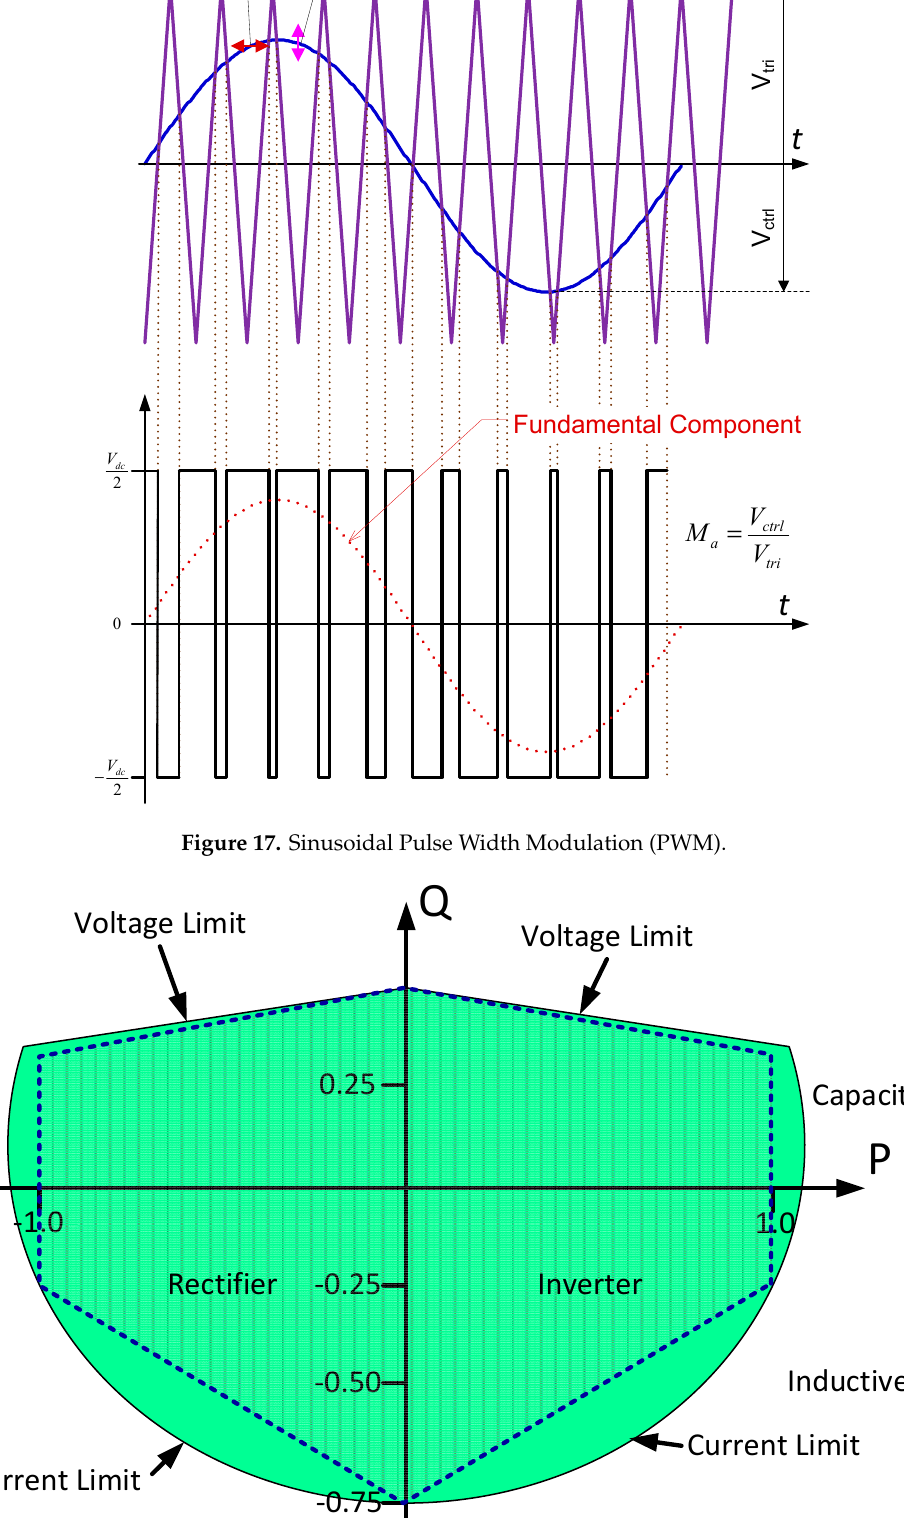
Figure 18. PQ diagram of VSC operating area.